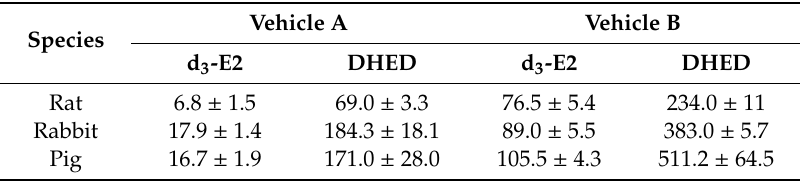
Table 1. Transcorneal flux (J ss , pmol · cm − 2 · h − 1 ) of DHED versus E2 at 10 µ M substrate concentration at saline (Vehicle A) and 20% w / v HP β CD in saline (Vehicle B), respectively, in rat, pig, and rabbit corneas ex vivo. Data are given as average ± SD ( n = 3) 1